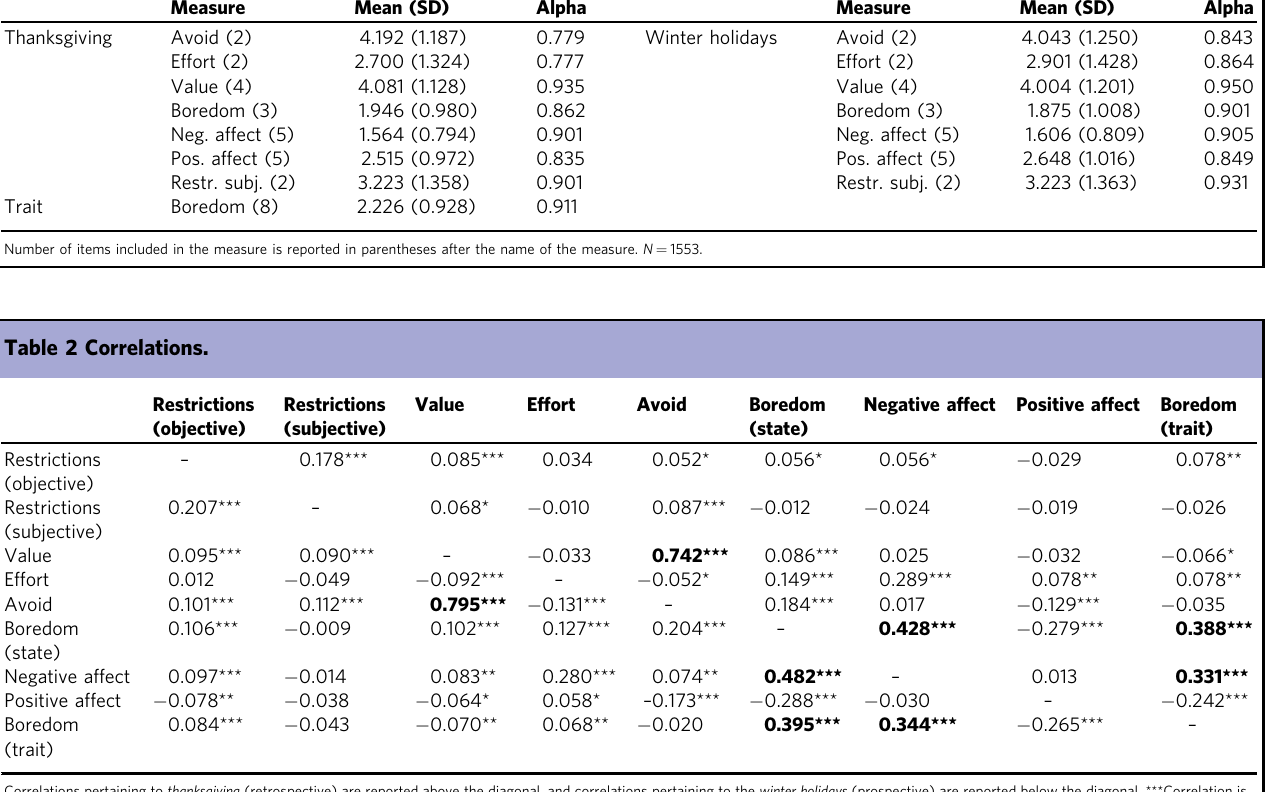
Correlations pertaining to thanksgiving (retrospective) are reported above the diagonal, and correlations pertaining to the winter holidays (prospective) are reported below the diagonal. ***Correlation is signi fi cantatthe0.001level(two-tailed),**Correlationissigni fi cantatthe0.01level(two-tailed),and*Correlationissigni fi cantatthe0.05level(two-tailed).Mediumandstrongcorrelationsarewritten in bold ( r >0.3). N = 1549 for the variable objective restrictions (coded as 0 for the US states without restrictions) otherwise N =